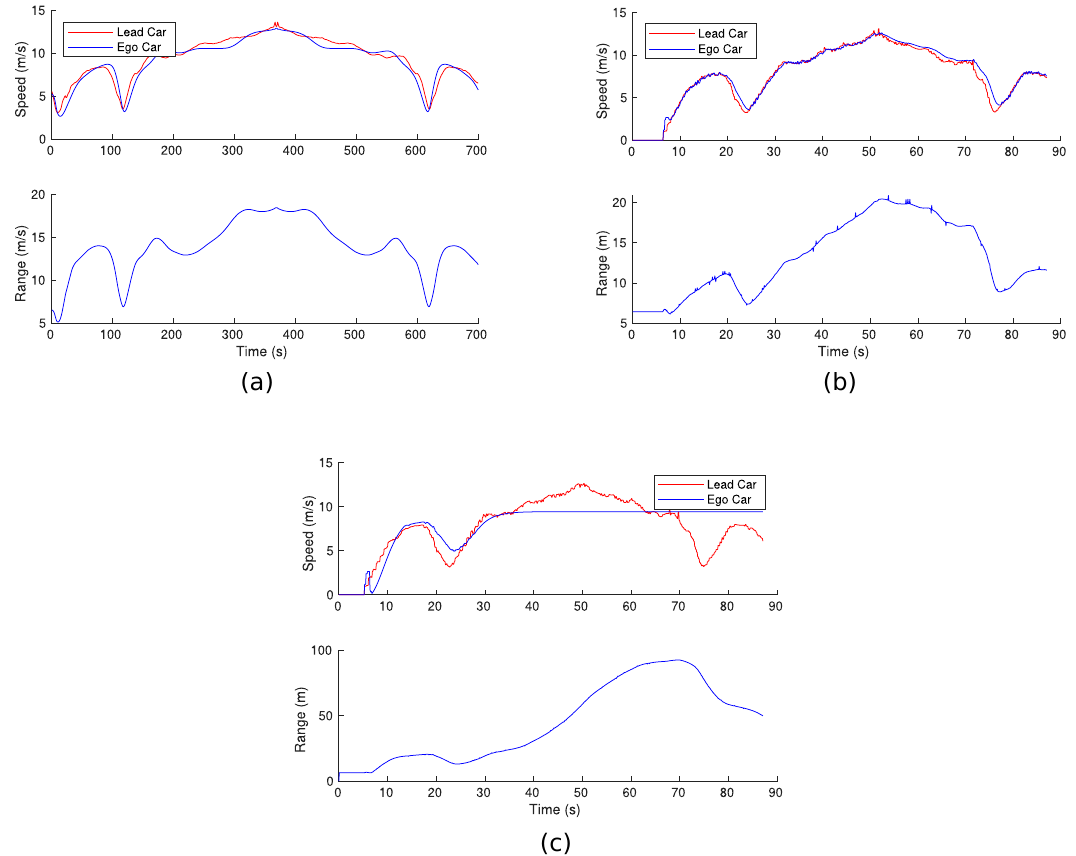
Figure 11. Profiles from the car-following simulation: ( a ) speed and range profiles from the actual real-road driving data; ( b ) speed and range profiles from the car-following simulation based on the proposed model; ( c ) Speed and range profiles from the car-following simulation based on Gipps’ driver